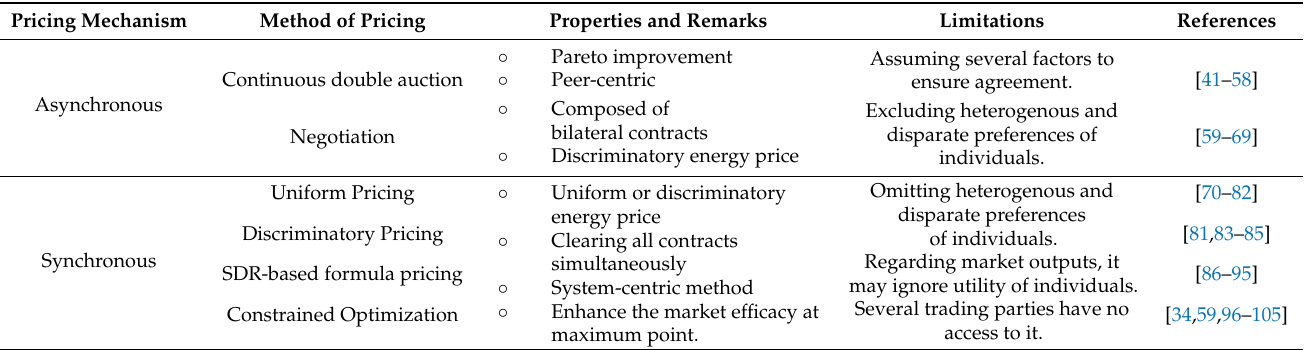
Table 3. Summary of methods used for energy